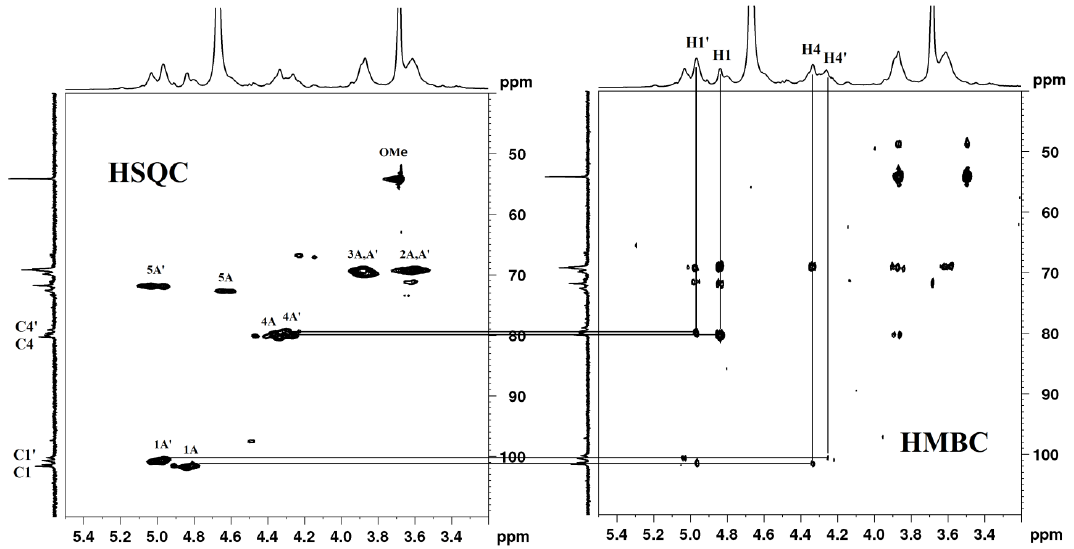
Figure 6. HSQC (heteronuclear singular quantum correlation) and HMBC (heteronuclear multiple bond correlation) spectra of TPS1-2a and/or TPS1-2b.